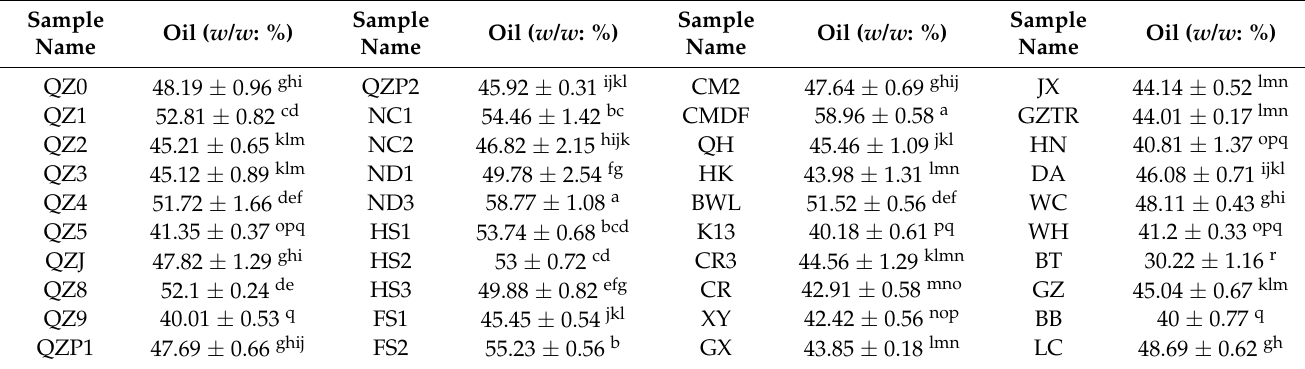
Table 2. The oil content of the different